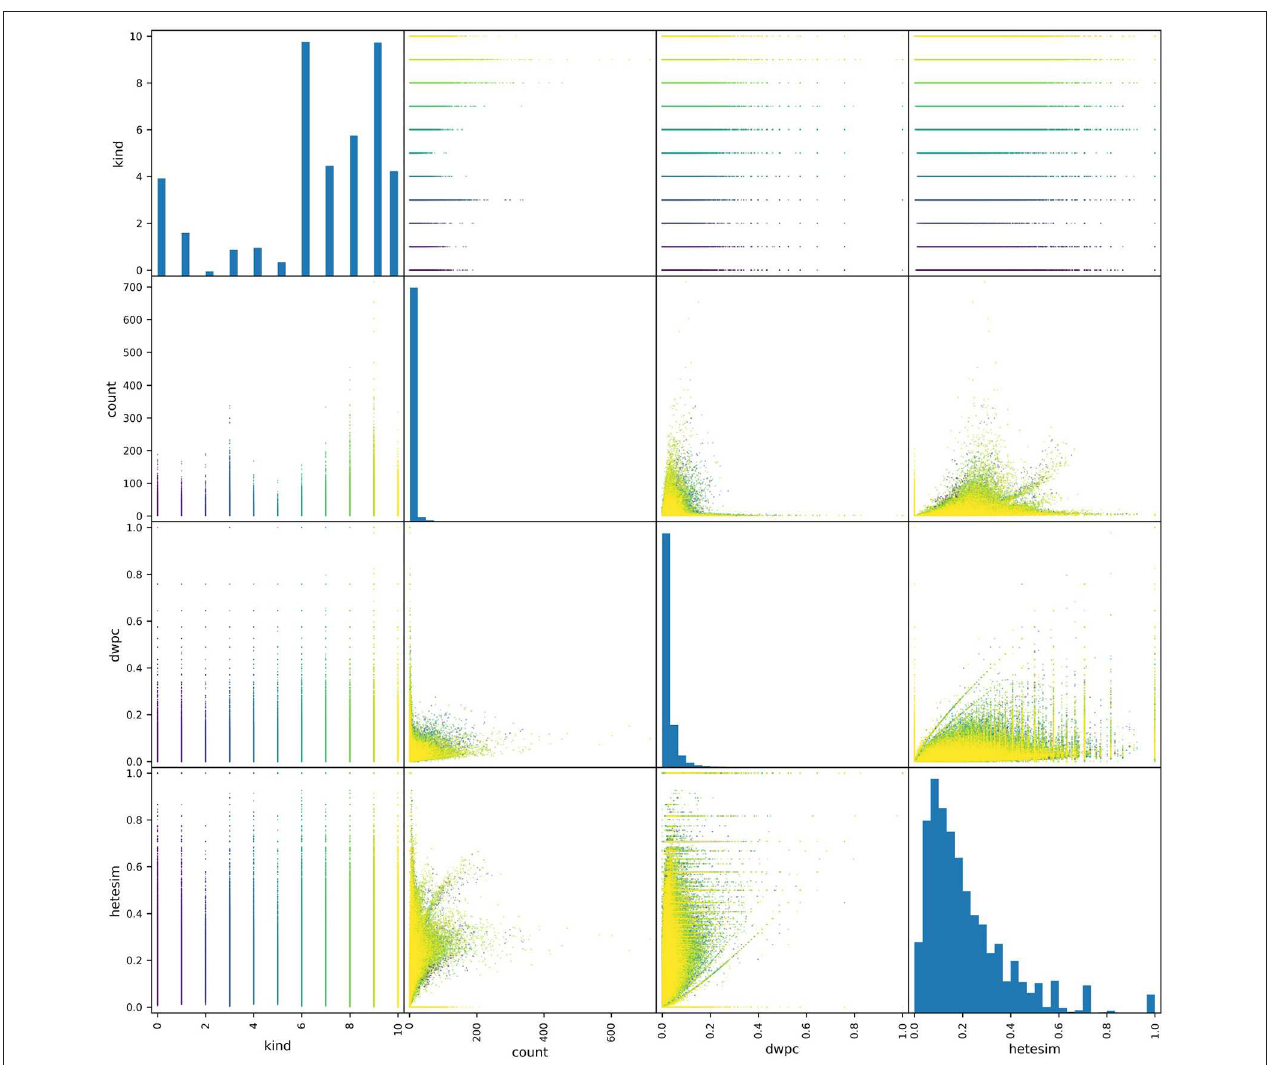
FIGURE 5 | A pair plot showing correlations between metapath-based features across a set of source nodes of different types. All non-zero features were plotted, where each point represents the feature values of a metapath for a given source-target pair. A total of about a half-million points are colored according to their source type. More distribution represents a less-biased ranking feature. Thus, HeteSim, which has the most distribution or “diversity,” is the least biased feature for the use case